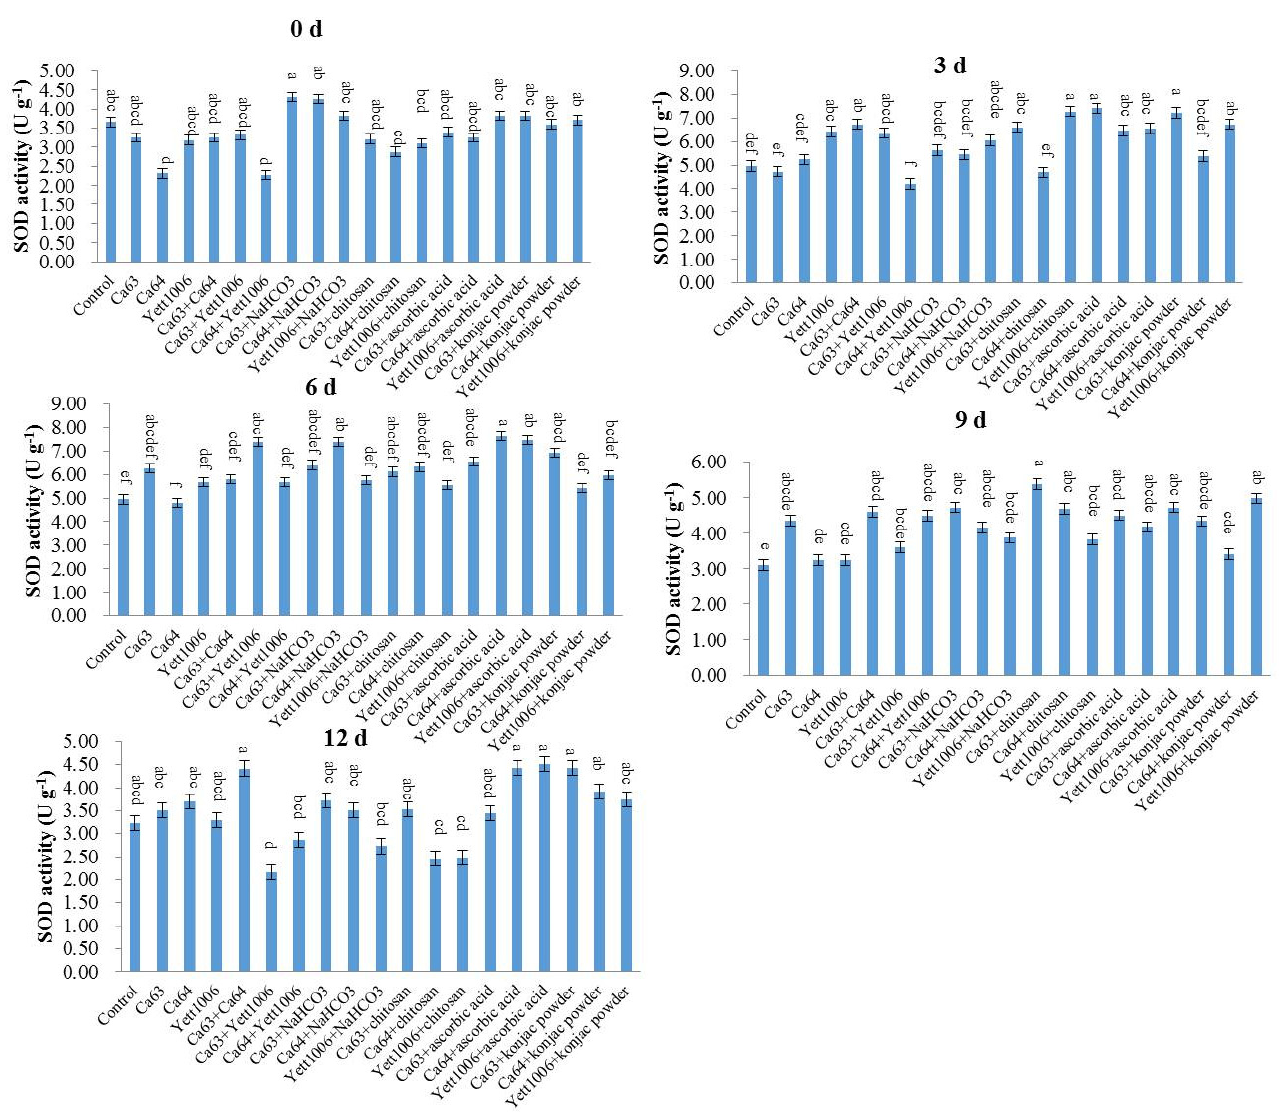
Figure 10. Evaluation of SOD activity in snap beans between different treatments. Error bars represent the standard deviations of means ( n = 3). On the bars, the small letters indicate a significant difference in the treatment according to Duncan’s multiple difference test ( p < 0.05).